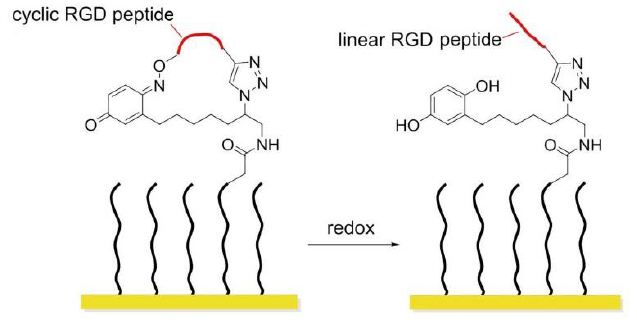
Figure 18. Redox-switchable polymers. In the cyclic form, the RGD sequence is blocked and inactive; after redox, the RGD peptide is exposed.